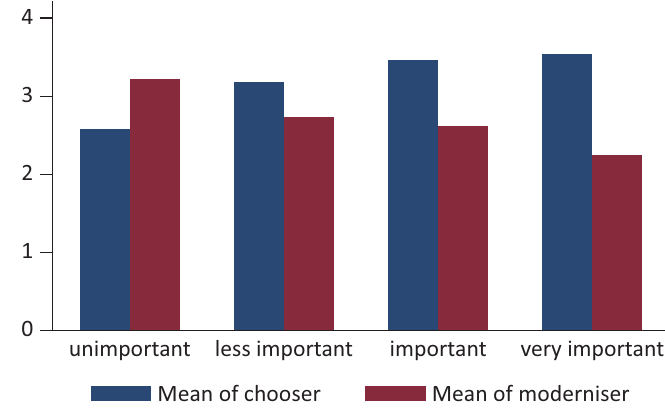
Figure 2. Mean values scores for choosers and modernisers within the four categories evaluating travel (unimportant, less important, important, very important). Source: SOEP (2019), own